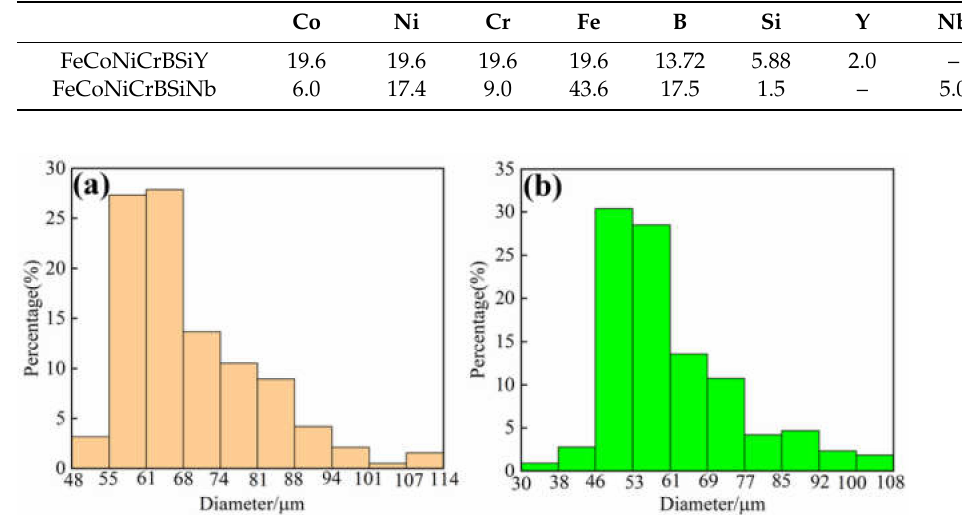
Figure 1. Particle size distribution of raw powders: ( a ) FeCoNiCrBSiNb; ( b ) FeCoNiCrBSiY.